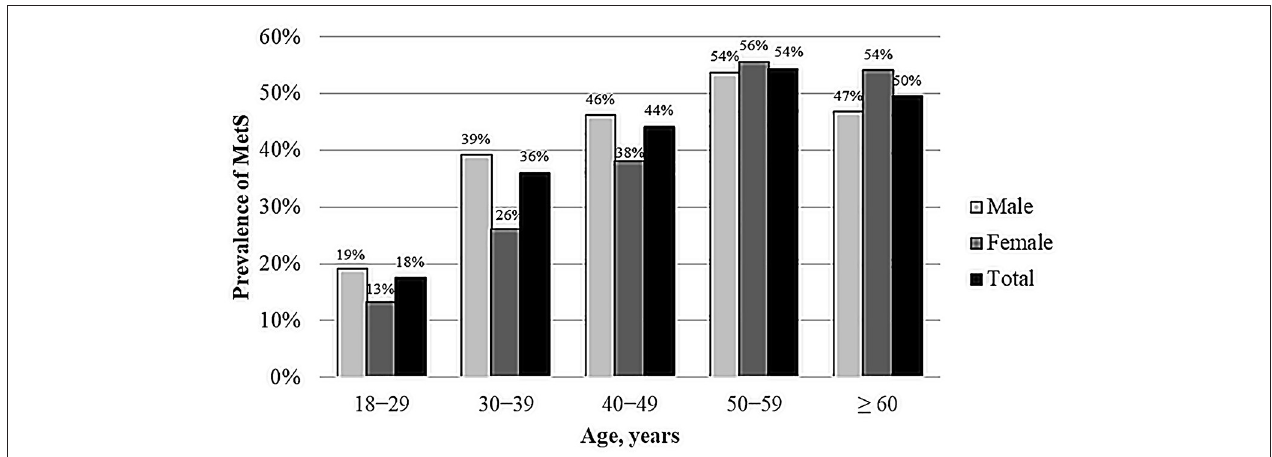
FIGURE 1 | Gender and age-specific prevalence of metabolic